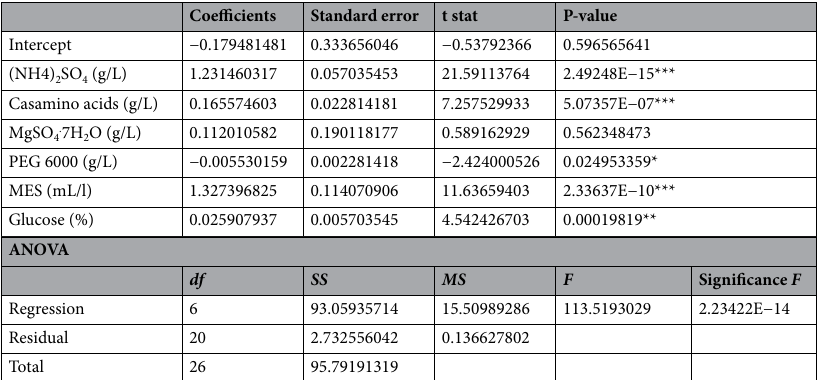
Table 2. Analysis of variance (ANOVA) results for Taguchi design experimental design results used to maximize the cell dry weight of strain E56. Multiple R = 0.96, R 2 = 0.97, AdjR 2 = 0.96, R-sq(pred); 0.94, SE = 0.37. *Significant